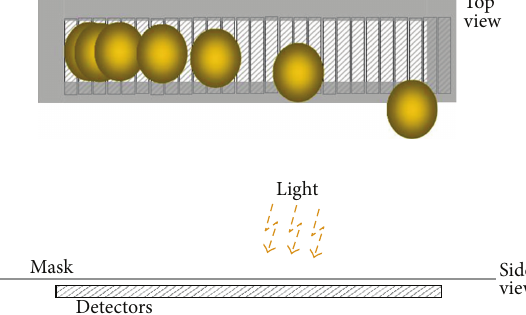
Table 1: LRS parameters.